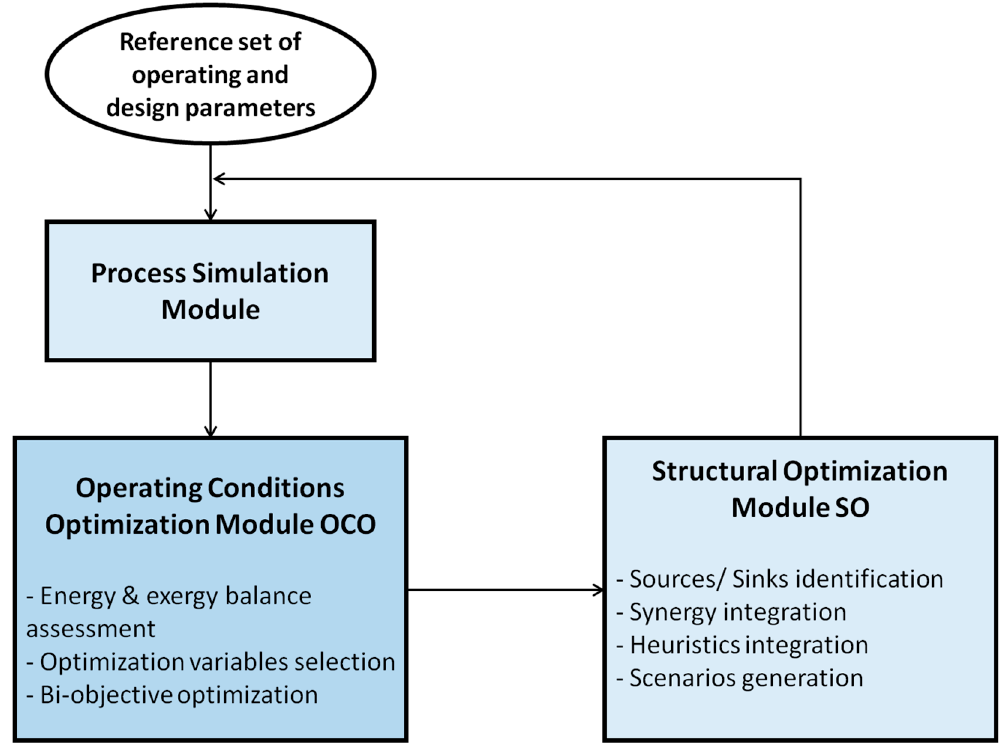
Figure 1. Global pattern of the proposed methodology.